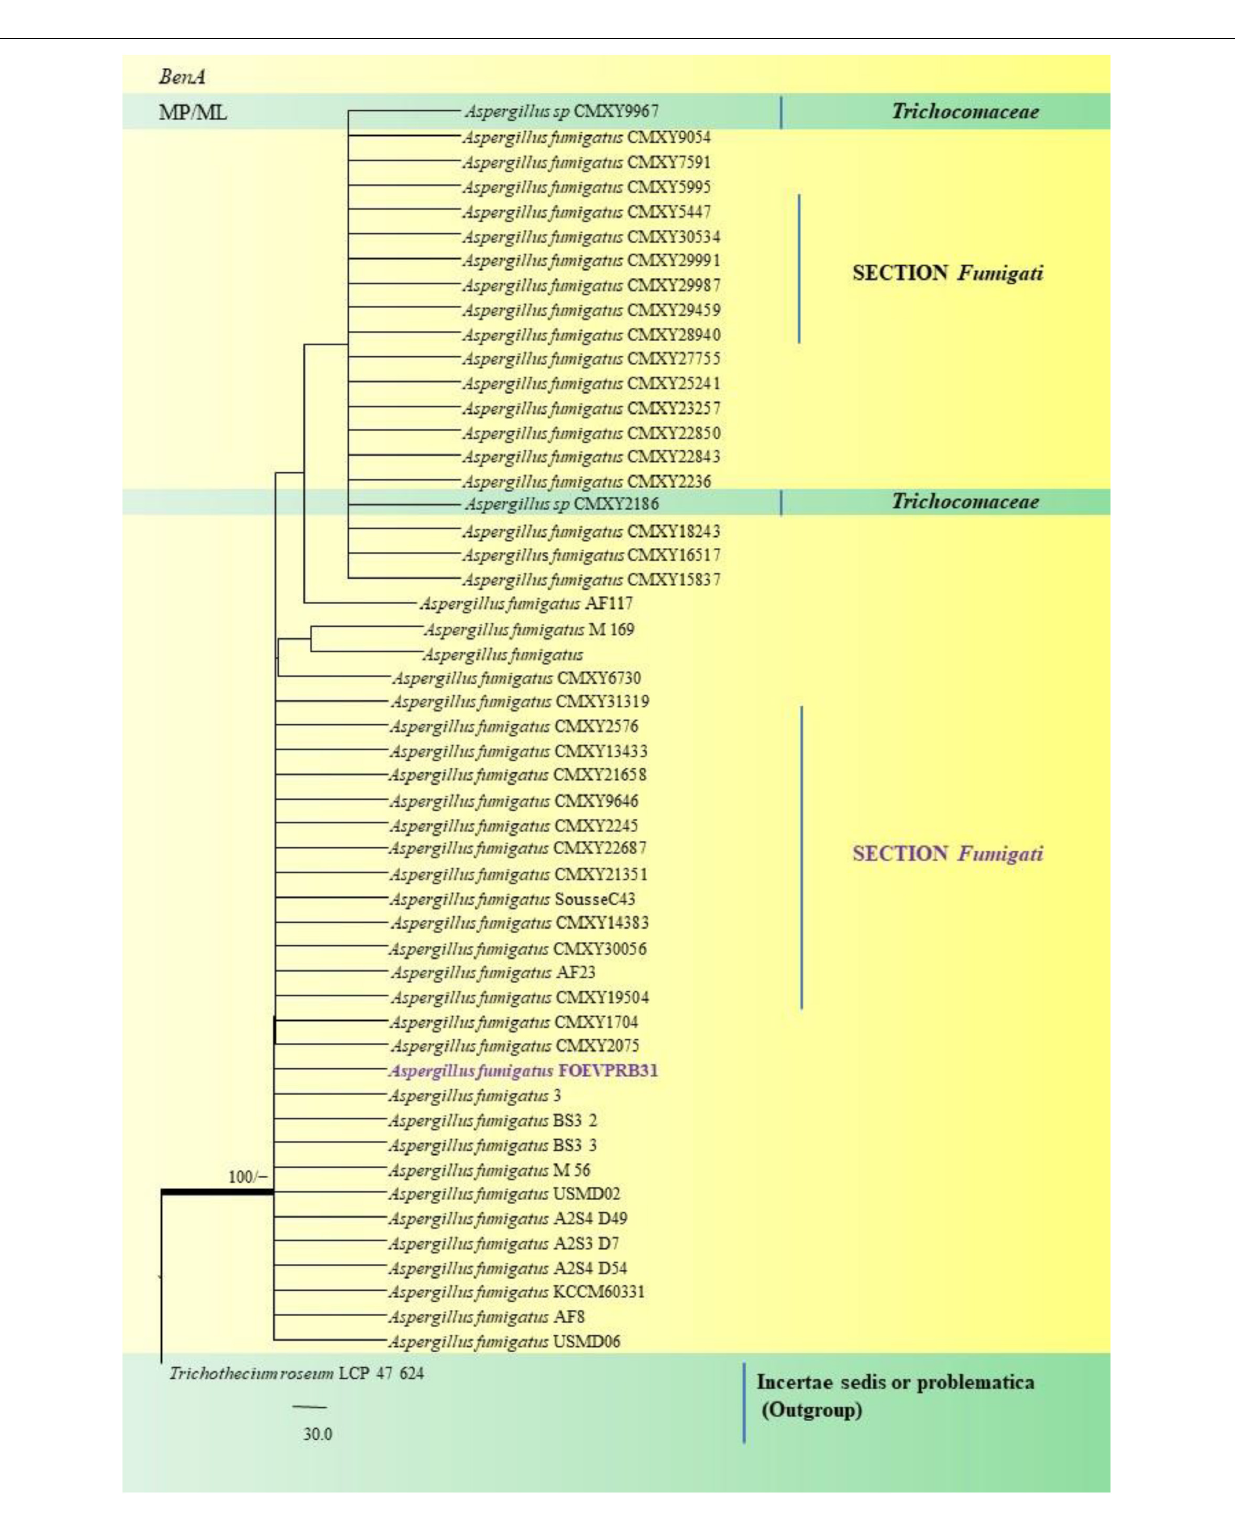
FIGURE 13 | A phylogenetic tree (taxon branching diagram) which presents the genetic analysis of the Aspergillus fumigatus FOEVPRB31 clade belonging to the Section Fumigati exhibiting a maximum parsimony analysis of partial β -tubulin concatenated sequences, acquired. Bootstrap (bs) values ≥ 70% are designated at the nodes for maximum parsimony (MP) and maximum likelihood (ML) methods; branches with values ≥ 95% bs are bold black. A specific isolate code was mentioned as a suffix to the species name. Hyphen (-) represents the range of support values for parsimony and RAxML analyses of below 70%. Our isolate, which is marked in purple, was rooted using Trichothecium roseum LCP 47